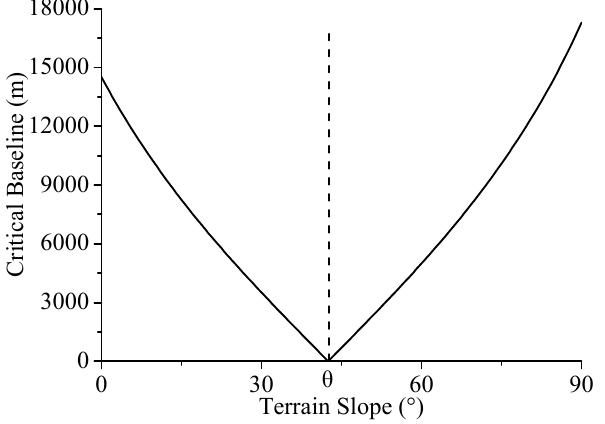
Figure 8. Critical baseline versus the terrain slope. The SAR system parameters are the same as those mentioned in Section 3.